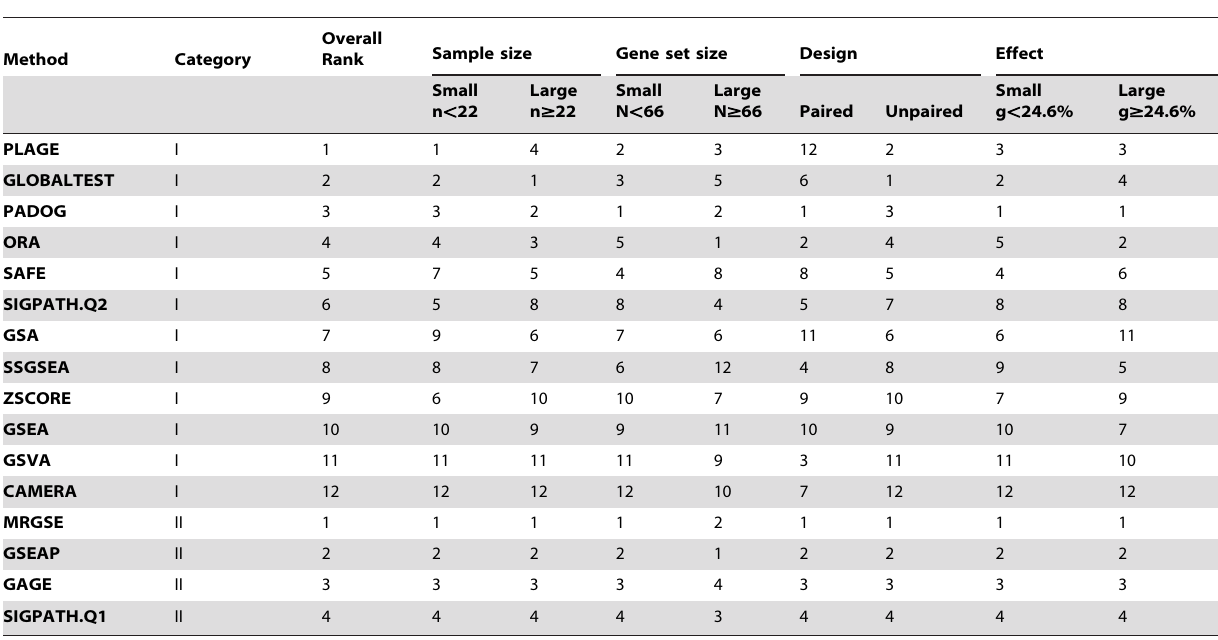
Table 2. Ranking of gene set analysis methods under several